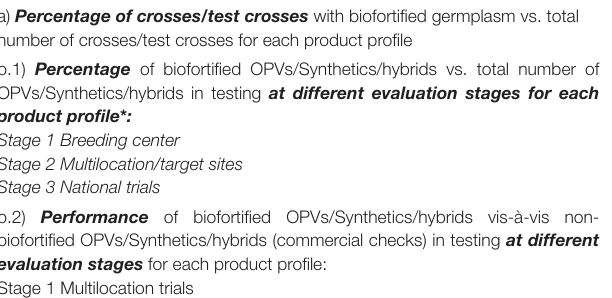
product profile * : Stage 1 Breeding